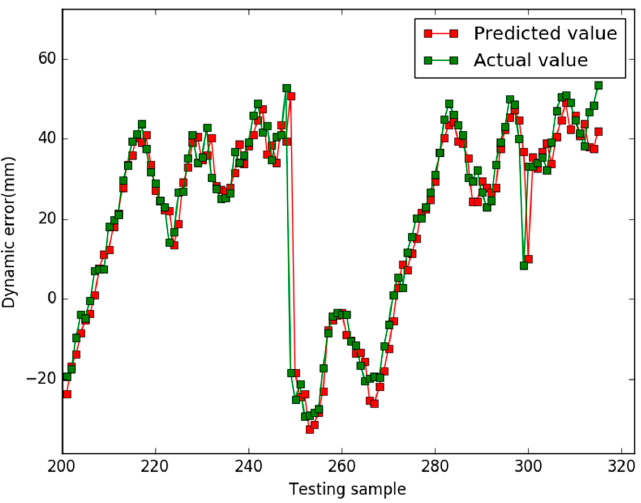
Figure 5. Predicted results of the NAPSO-SVM (case 2).